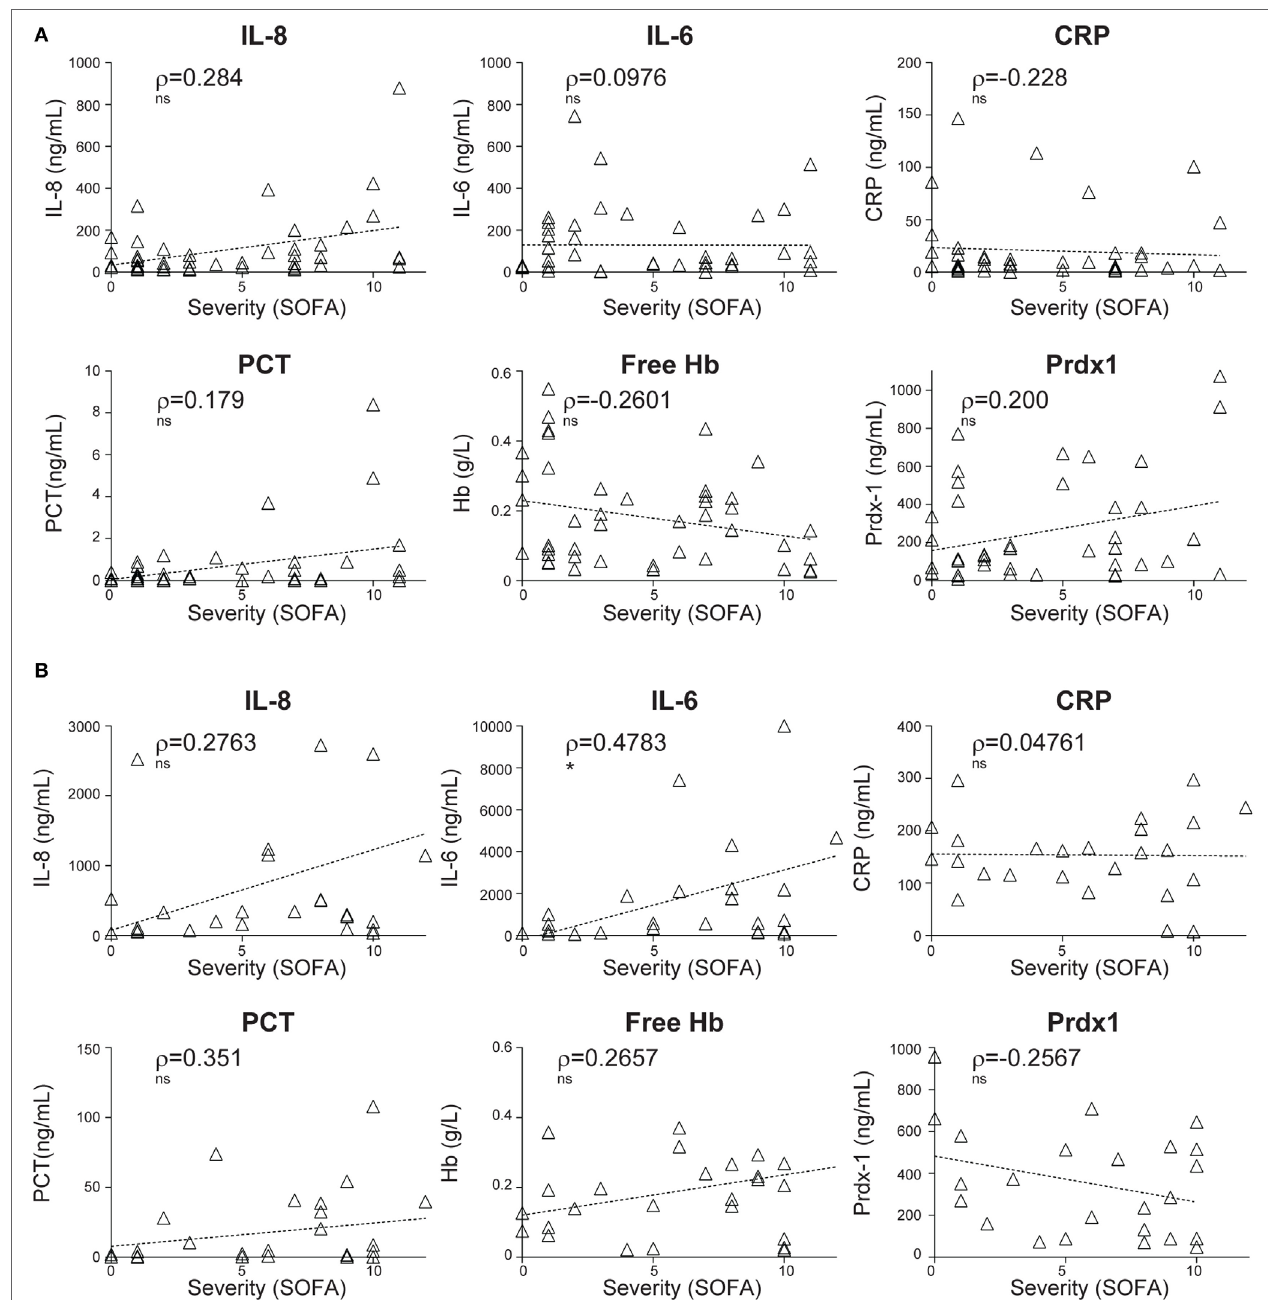
FigUre 2 | Correlations of plasma levels of inflammatory cytokines and stress mediators with the severity of non-infective systemic inflammatory response syndrome and sepsis. The levels of inflammatory cytokines (interleukin-IL-8 and IL-6) and stress mediators: C-reactive protein (CRP), pro-calcitonin (PCT), free hemoglobin (Hb), and peroxiredoxin-1 (Prdx-1) were measured by ELISA in the plasma of non-infective SIRS (a) and sepsis (B) patients. Thereafter, the correlation with the severity of disease, as determined by the sequential organ failure assessment (SOFA) score was investigated. (a) Non-parametric correlation of SOFA scores with the plasma levels of IL-8 ( n = 43), IL-6 ( n = 43), CRP ( n = 43), PCT ( n = 42), free Hb ( n = 43), and Prdx-1 ( n = 41) in non-infective SIRS patients. (B) Non-parametric correlation of SOFA scores with the plasma levels of IL-8 ( n = 26), IL-6 ( n = 27), CRP ( n = 27), PCT ( n = 27), free Hb ( n = 27), and Prdx-1 ( n = 24) in sepsis patients. Each triangle represents an individual patient. Correlation trends are shown with the linear regression model, including Spearman rho ( ρ ) and the significances of the correlations (* p ≤ 0.05; ** p ≤ 0.005; and *** p ≤ 0.0005 or ns, non-